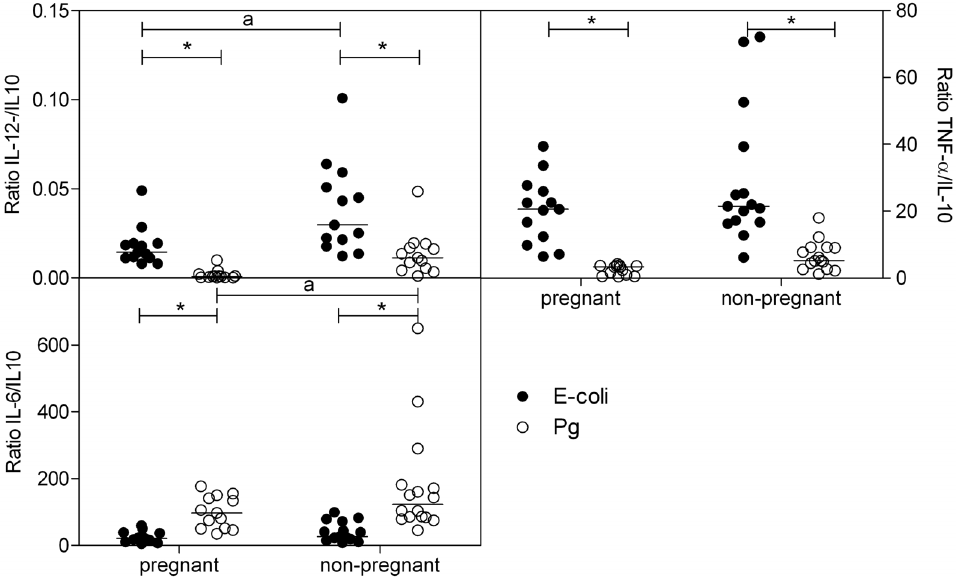
Figure 4. Pro-inflammatory/anti-inflammatory cytokine ratio following stimulation with bacteria. Ratio of Il-12/IL-10, TNF a /IL-10 and IL- 6/IL-10 cytokine production in plasma of pregnant and non-pregnant women following stimulation of whole blood with E-coli (black dots) or P. Gingivalis (PG) (open dots) bacteria (5*10 7 bacteria/ml) for 24 hr. *significantly different from E-coli (two-way ANOVA followed by Bonferroni post- tests, p , 0.05). a: significantly different from pregnant women after the same stimulation (two-way ANOVA followed by Bonferroni post-tests,